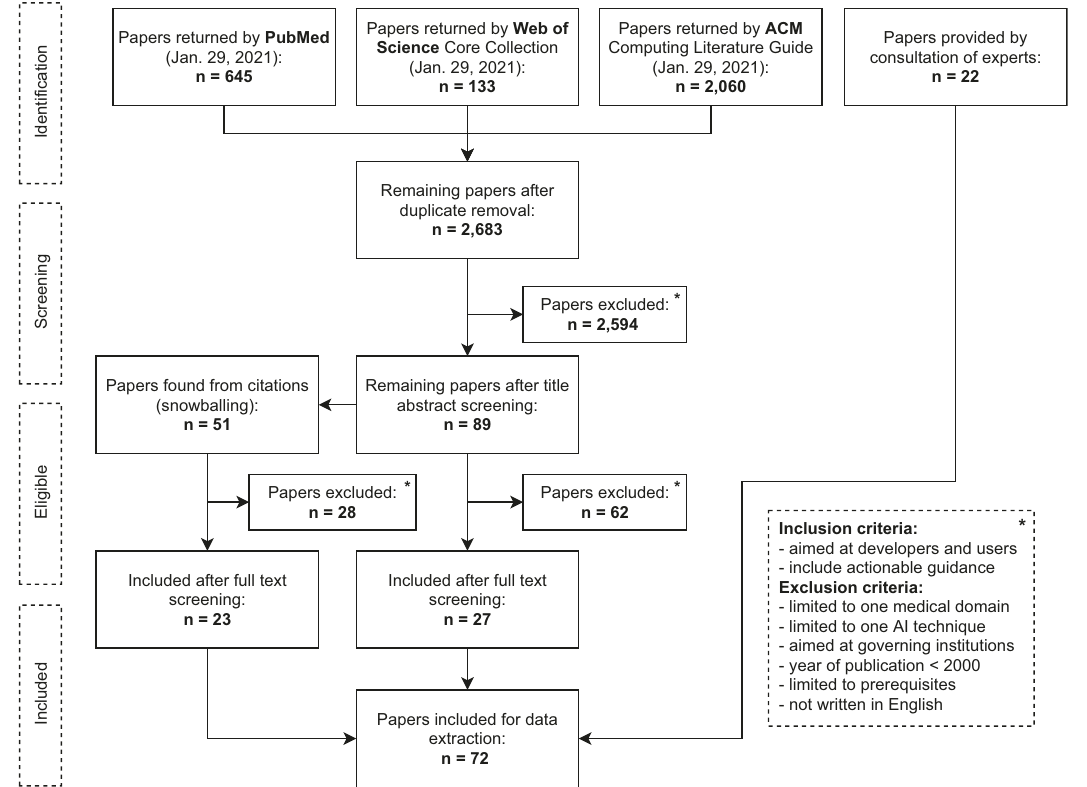
Fig. 1 Flow diagram of screening strategy. This fl ow diagram displays the screening strategy for the inclusion of guidance documents in this scoping